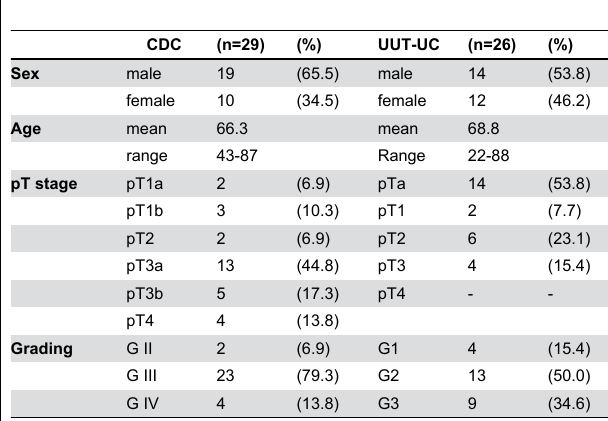
Table 1. Characteristics and clinical data of patients with CDC and